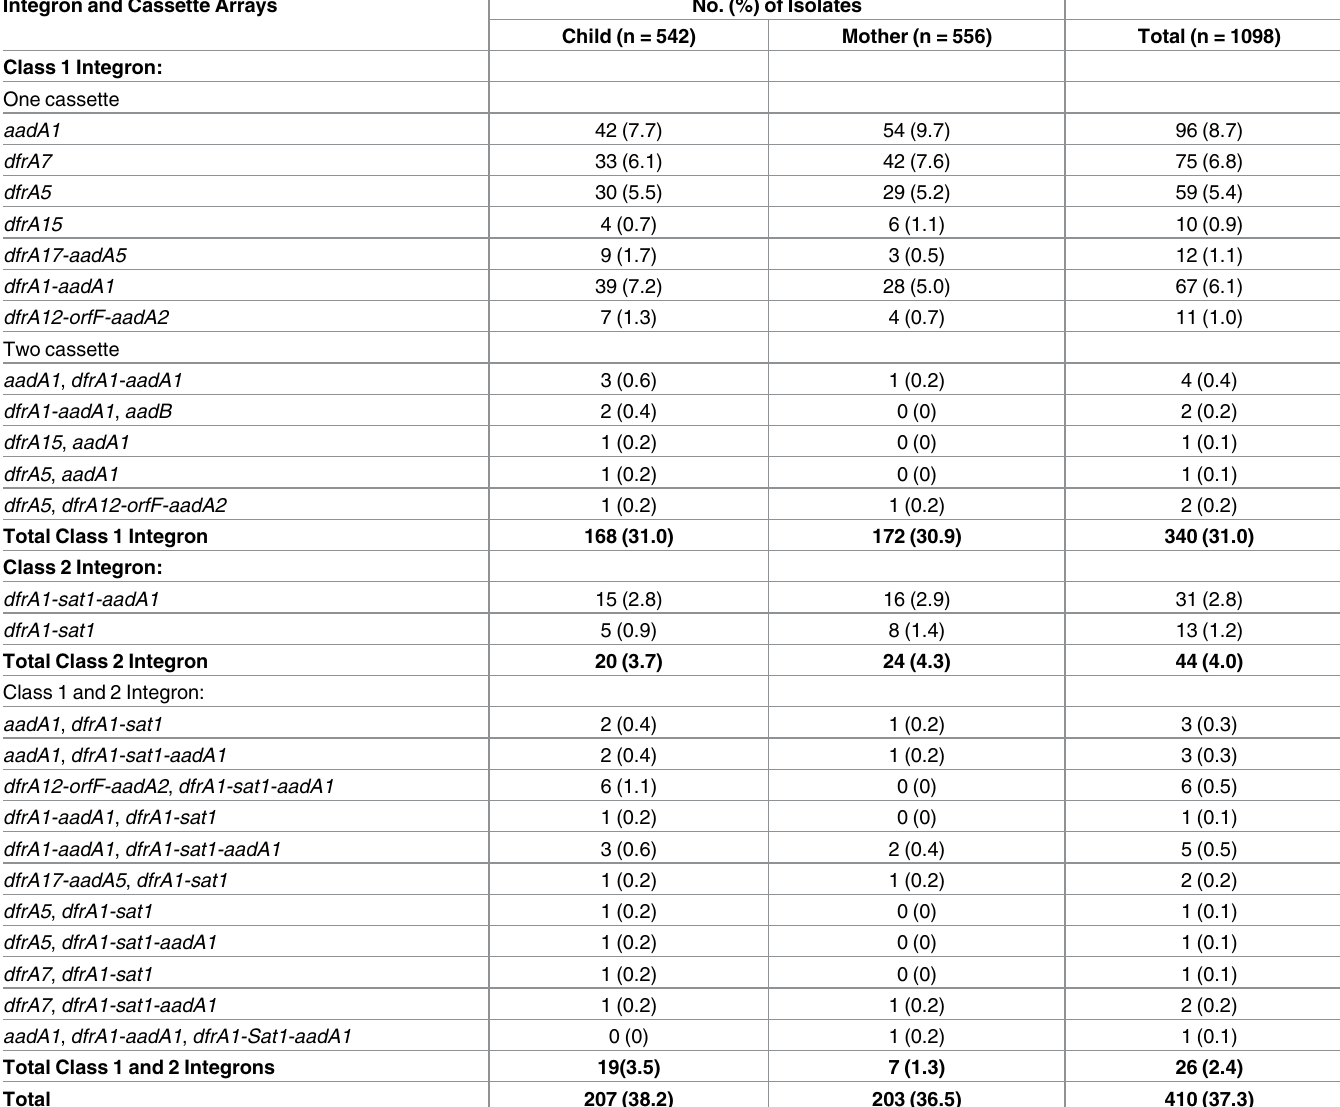
Table 3. Number of integrons and different cassettearraysoccurring in faecal Escherichia coli isolated from mother-child pairs. Integron and Cassette